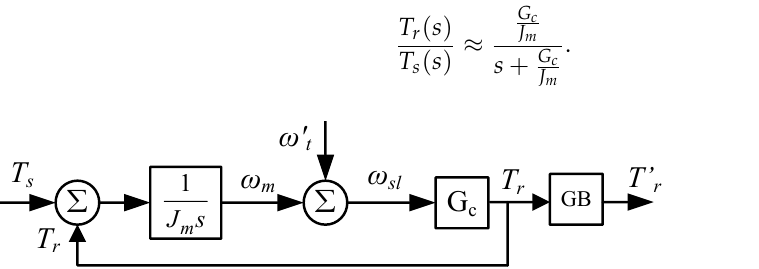
Figure 5. Block diagram model illustratrating the relationship between the torque of the PMSG and the torque of the S-PMC in an SS-WTS (see Figure